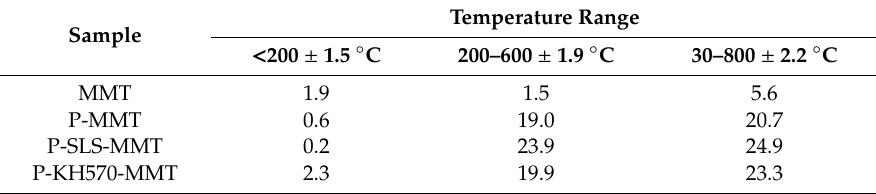
Figure 4. ( A ) Thermogravimetric analysis (TGA) and ( B ) Derivative thermogravimetry (DTG) curves of MMT, P-MMT, P-SLS-MMT, and P-KH570-MMT. Table 1. Relative mass loss during decomposition of investigated samples (wt %).